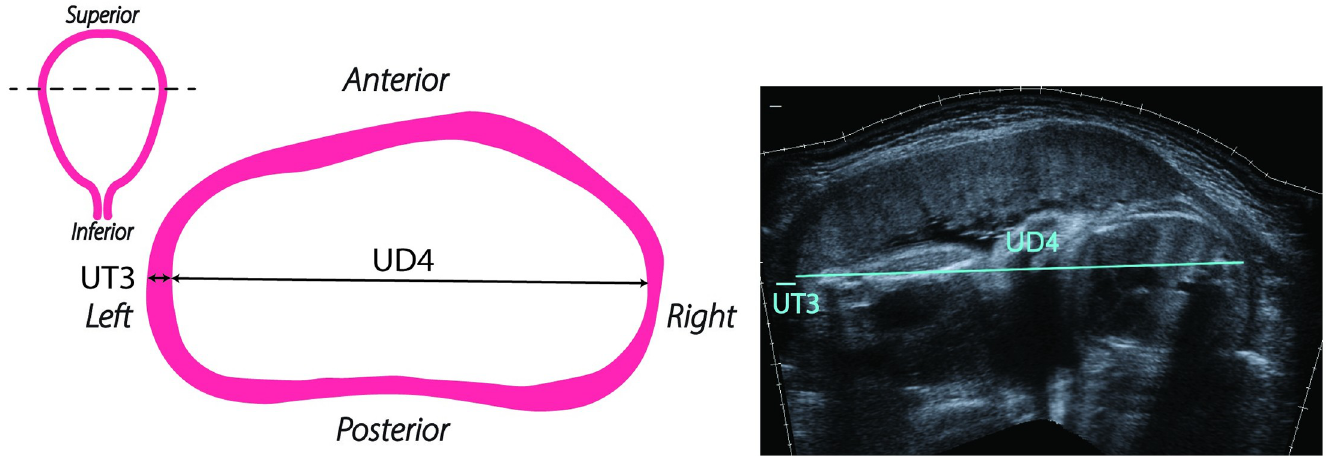
Fig 3. Representative and actual transabdominal (TA) axial scan of a pregnant patient at 32 weeks. Left: coronal uterine outline with the ultrasound sweep location shown with a dashed line, and a representative illustration of measurements taken from ultrasounds of the uterus in the axial view. Right: actual transabdominal (TA) axial view of the uterus taken as a extended field-of-view ultrasound sweep from left to right at the widest section of the uterus. Measurements taken from the TA axial view are either left or right uterine wall thickness (UT3) and left-right uterine diameter (UD4).